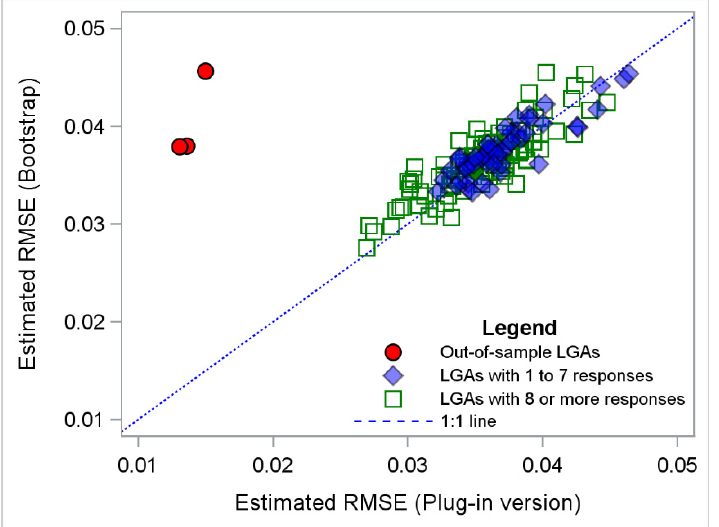
Figure 4. Bootstrap versus plug-in RMSEs for LGA-level EBP model-based estimates of proportion of smoking in males, 2006, using a generalised linear mixed model with logit link. The model included age group, marital status, education level and private health status. Table 1. Summary statistics for estimated RMSE using output from the GLIMMIX procedure, parametric